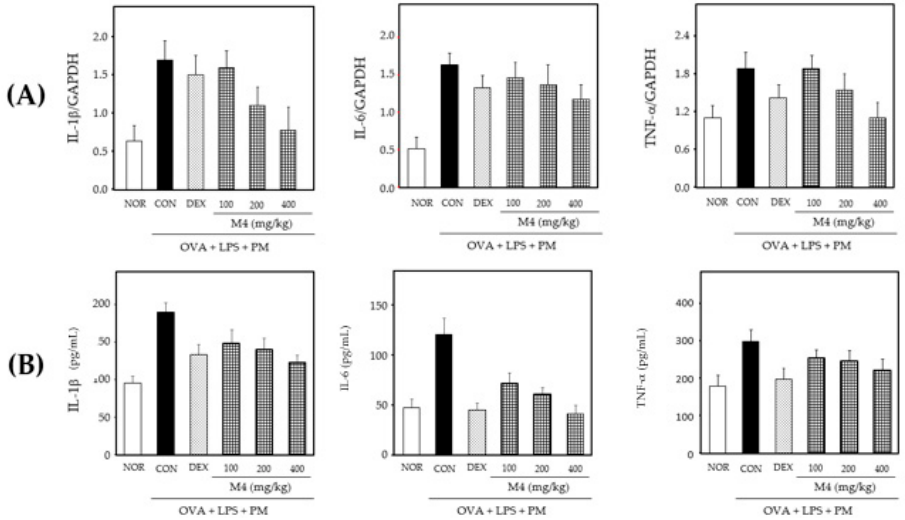
Figure 4. Anti-inflammatory effects of M4 in OVA-, LPS- and PM-induced asthmatic rat model. ( A ) Gene expression and ( B ) generation of proinflammatory cytokines IL-1 β , IL-6 and TNF- α in OVA- and LPS-challenged and OVA-, LPS- and PM-sensitized asthmatic SD rats. Data are expressed as the means ± SD ( n = 5). A value of p -value < 0.05 was considered statistically significant.